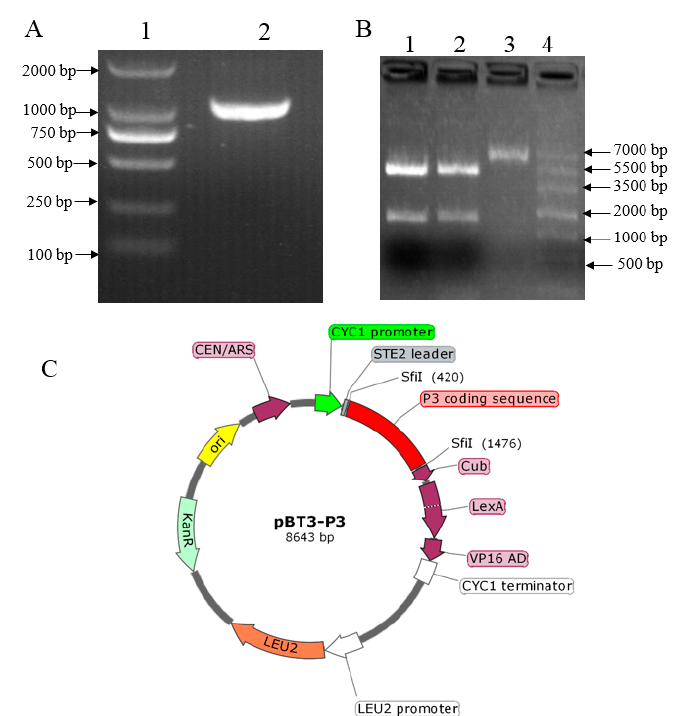
Figure 1. Construction and verification of the bait vector. ( A ) Gel electrophoresis image of P3 amplification from cDNA. Lane 1 is a DNA marker in which the strip size was written on the left, and lane 2 is the PCR product of P3 from cDNA. ( B ) Gel electrophoresis image of the digested recombinant plasmid. lane 1 and 2: pBT3-P3 digested by Sfi I; lane 3: pBT3 plasmid; lane 4: marker in which the strip size was indicated on the right. ( C ) The image of the plasmid pBT3-P3 construction.